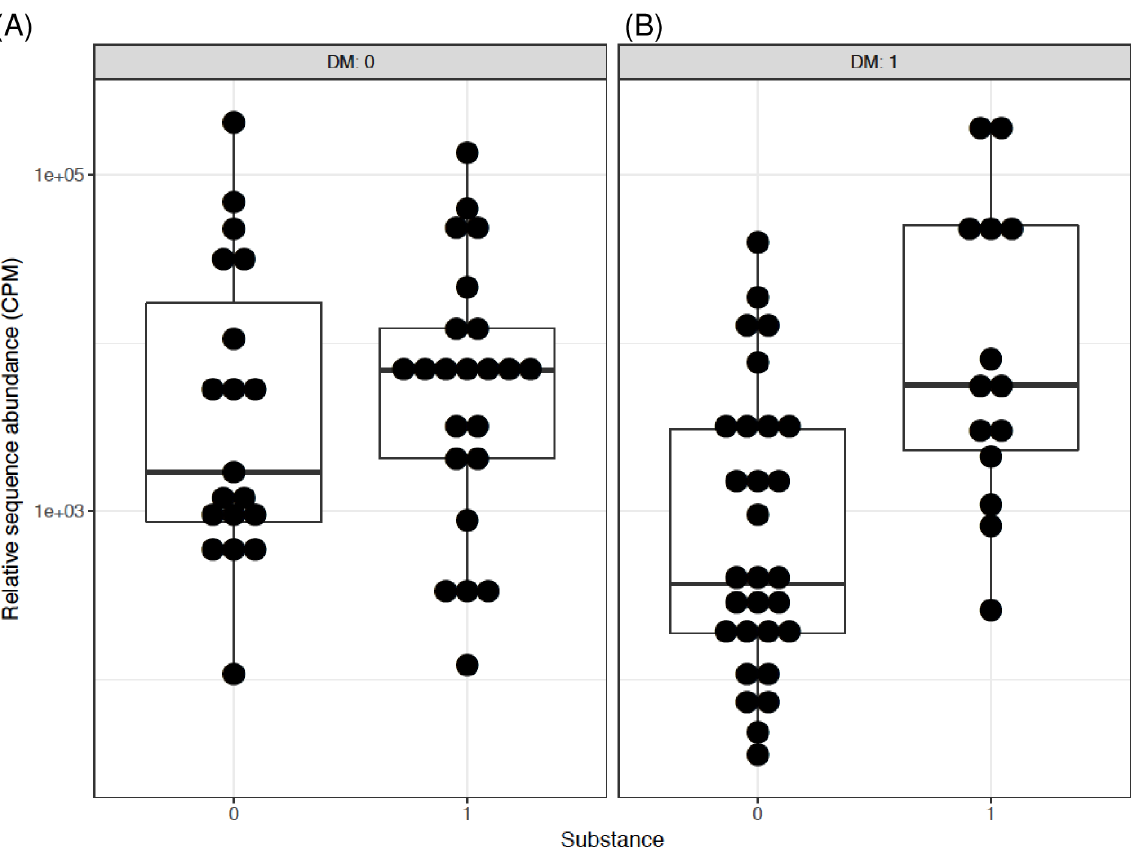
Fig 4. The interactive influence of opioids on Bifidobacterium genus in men with and without T2D. Data and analysis are the same as in Fig 3. (A) No difference between without vs. with opioids when both groups are without T2D. (B) 3.2 log2 fold increase in those with vs. without opioids when both groups have T2D (q = 2.5x10 -4